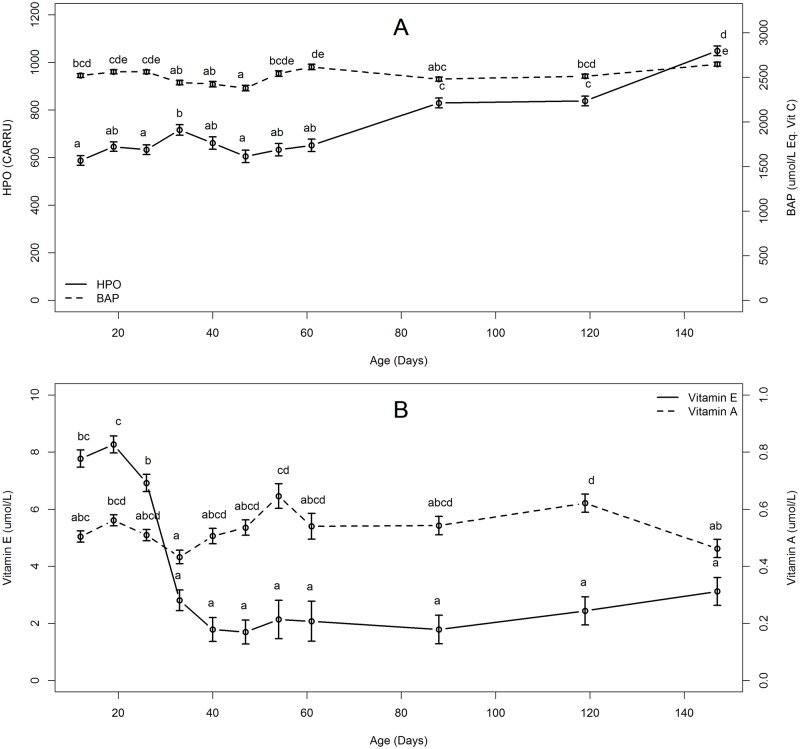
Plasma concentration of hydroperoxides (HPO), blood antioxidant capacity (BAP) (Fig 1A) and of vitamin E and A (Fig 1B) in pigs from 12 to 147 days of age (trial A).Half of the pigs were weaned at 21 days and half at 28 days of age. Least square means and standard error of mean (SEM) are shown. N = 64–66, excepted at 33 (n = 48) and between 40 and 61 days (n = 32). For each assay, means with different superscripts differ (P<0.05).